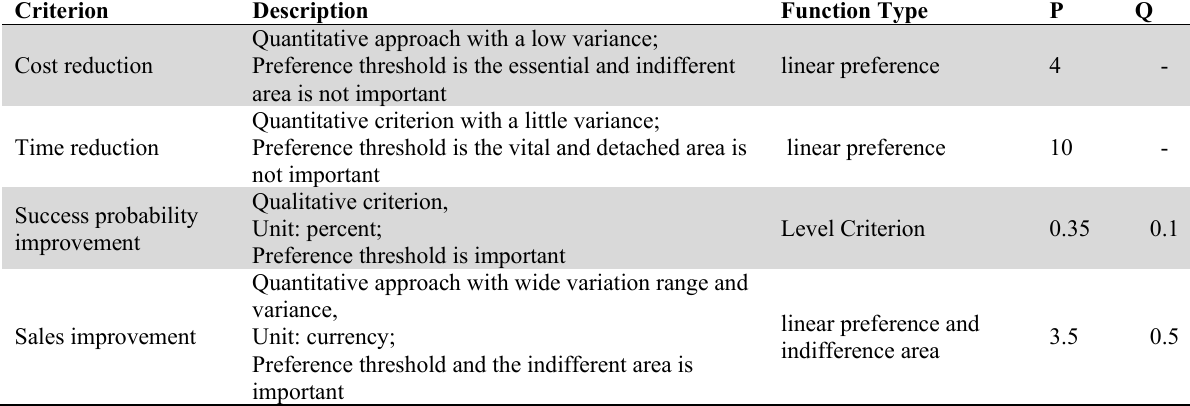
Criteria and type of preference functions in the Promethee II method for a numerical example